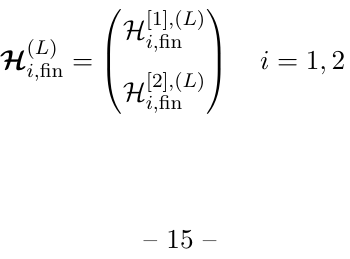
f F j and, only afterwards, substitute the finite form factors in eqs. (6.9) and (6.10),